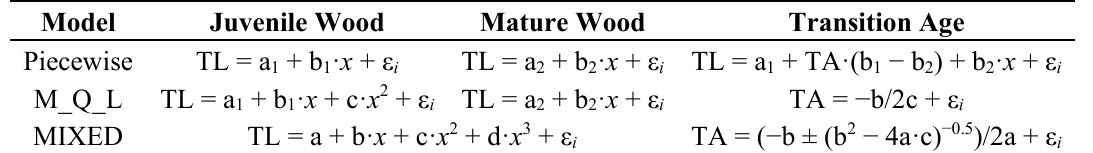
Table 4. Studied transition age